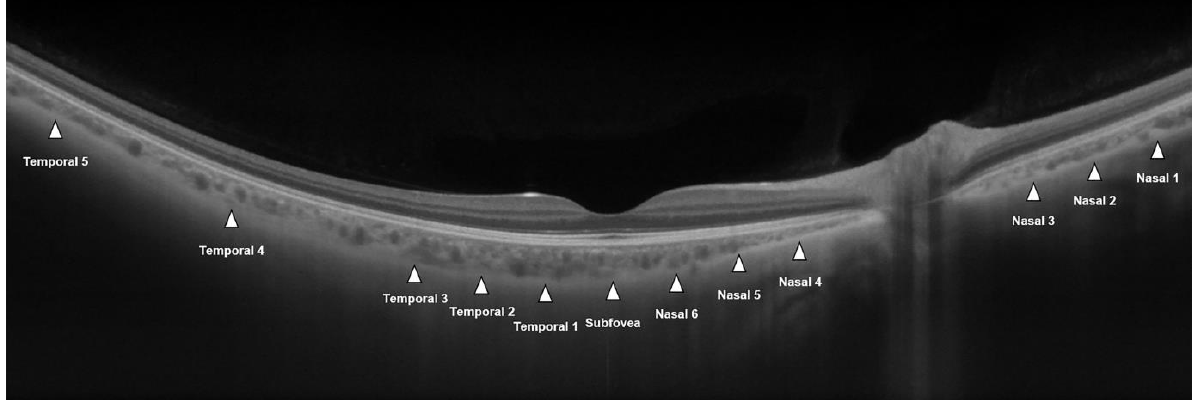
Figure 1. A 16-mm wide-field (16-mm) optical coherence tomography image of a healthy individual. Choroidal thickness was measured with a caliper at 12 points, i.e., at 900-µm intervals from the nasal optic disc margin (nasal points 1–3), at the subfovea, at 900-µm intervals from the fovea (nasal points 4–6 and temporal points 1–3), and at 2700-µm intervals from temporal point 3 (temporal points 4 and 5).